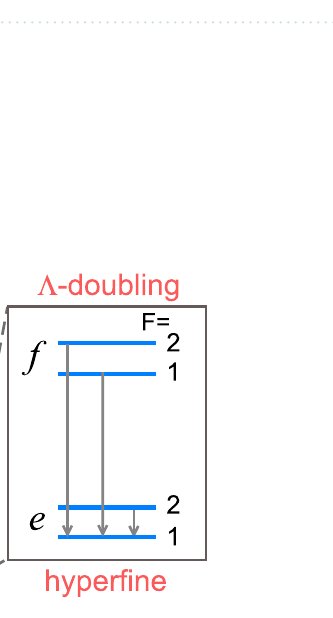
OH ( X 2 �) entrance channel is shown Figure 4. Collision or reaction path of the Sr + OH system. The Sr ( 1 S ) + H ( 2 S ) channel shown on the right on the left. Its energy is the zero of energy in the graph. The SrO ( X 1 � + ) + 1 and includes the difference in zero-point energy of OH and SrO. The three 2890cm is endothermic by hc − × states with negative energies in between are trimer states with collinear geometries that are (local) minima of the 1 2 A ′ ( X 2 � + ) and 4 2 A ′ ( F 2 �) electronic potentials as indicated. Electronic energies are taken from ab initio CCSD(T) calculations of Ref. 30 .